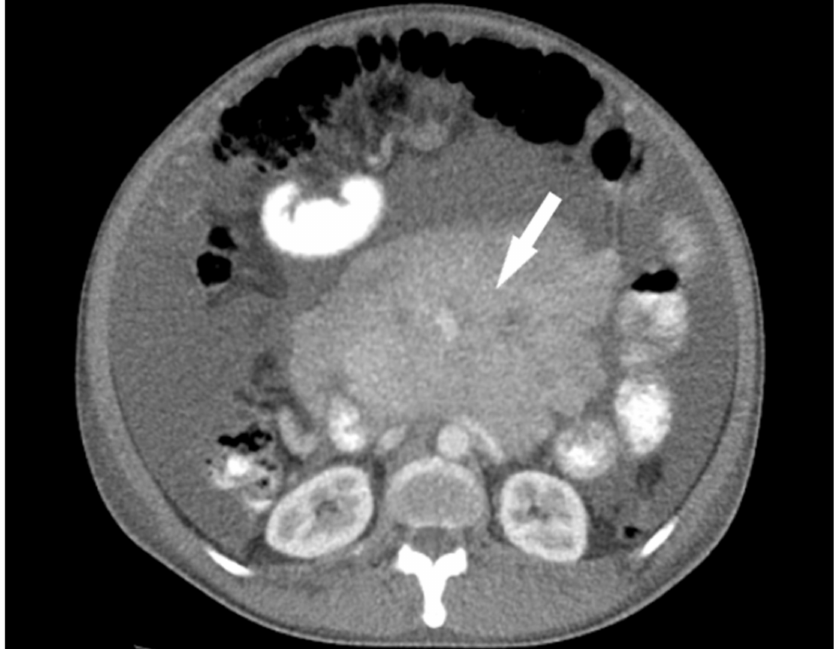
Figure 1. Tomographic image showing a retroperitoneal mass of 154 mm × 119 mm that extends to the mesogastrium (white arrow).